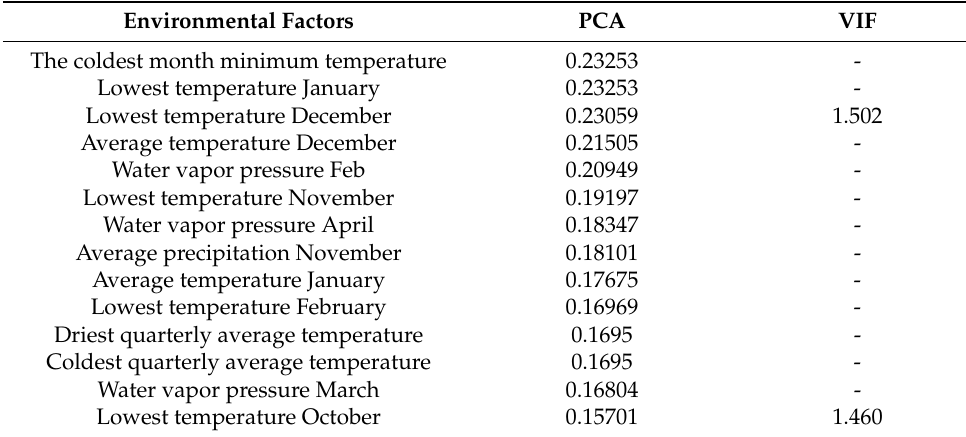
Table A3. Major environmental factors of sample sites.